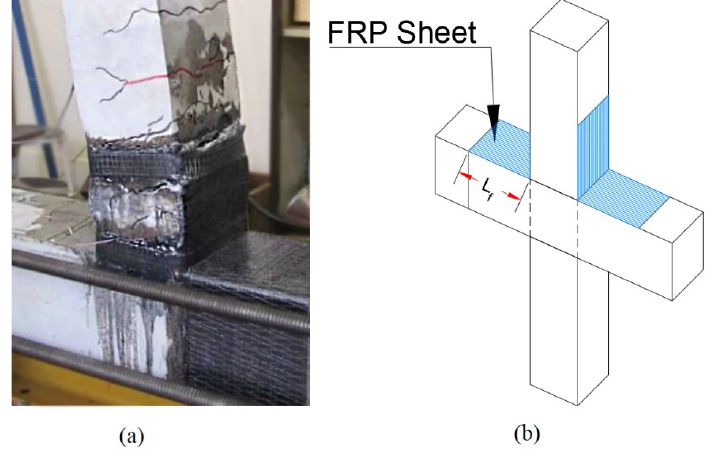
Figure 6. ( a ) Flange ‐ bonding CFRP and GFRP retrofitting system [34]. ( b ) Schematic scheme of flange ‐ bonding FRP retrofit in an interior joint.